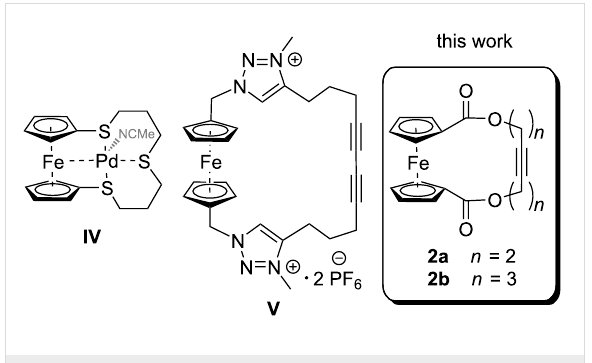
Figure 2: Examples for a ferrrocenic thiacrown ether complexing palla- dium ( IV ), and a dicationic ferrocenophane ( V ) featuring a diyne bridge for ion